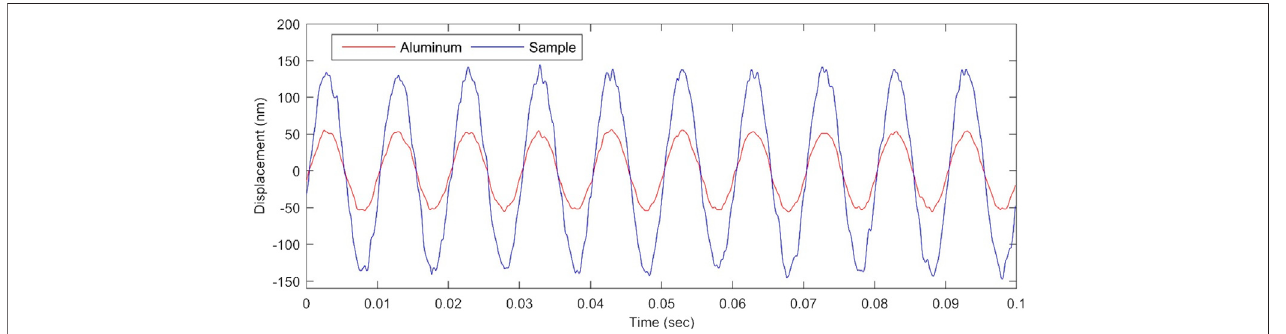
FIGURE 4 | Displacement signals of the sample and aluminum standard at 100 Hz.